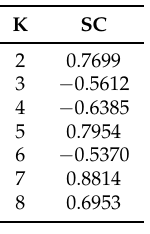
Figure 9. Curve of SC and K. Table 2. Numerical relationship of SC and K.